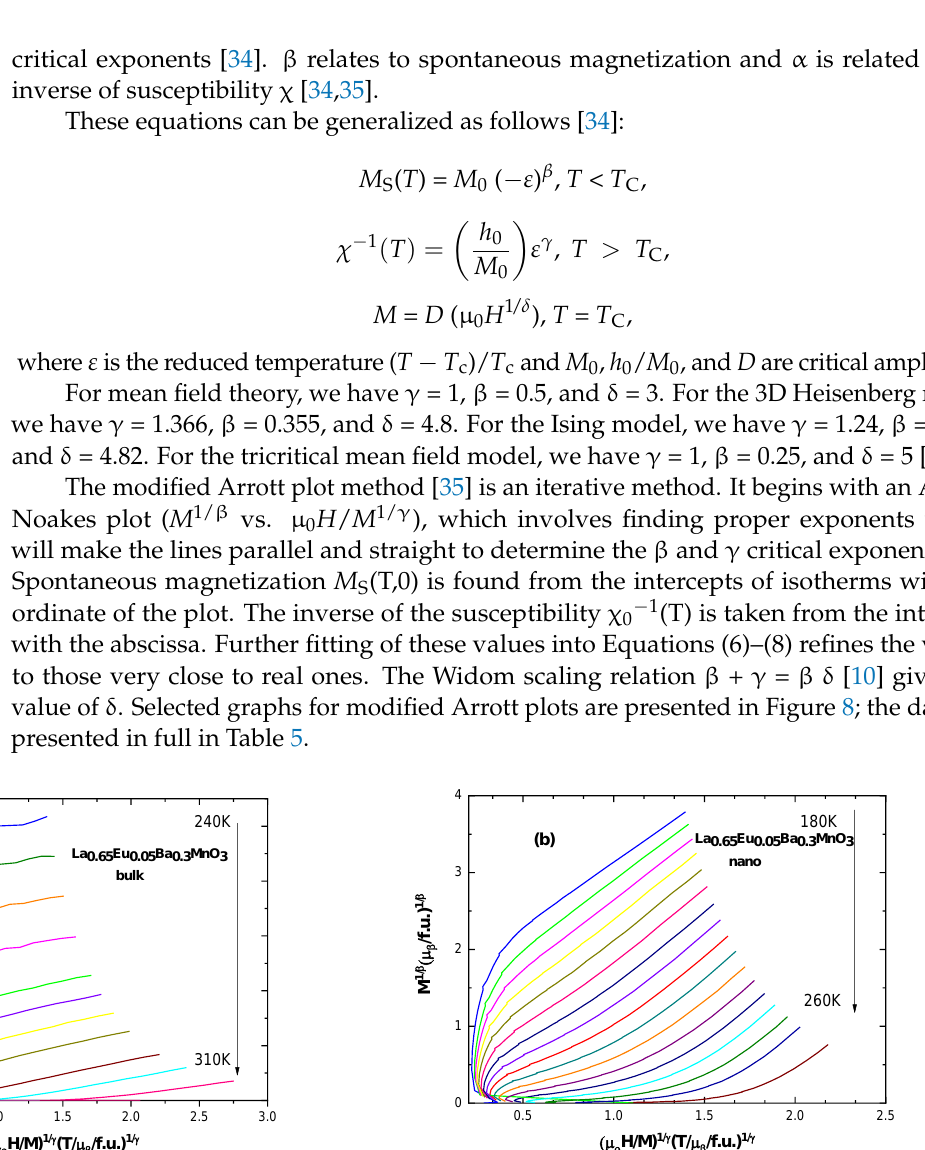
Table 5. Critical exponent values for all samples.